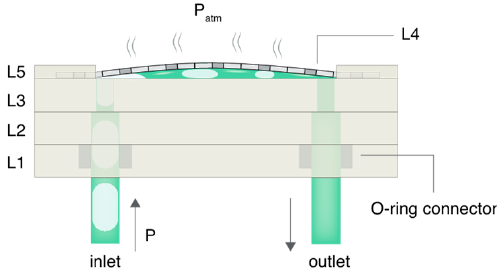
Figure 2. Schematic representation of the RID module in operation. Once the opening pressure P open is exceeded, the PTFE membrane (L4) deflects and exposes a fluidic path connecting the inlet and outlet. Bubbles in the input stream make contact with the hydrophobic PTFE membrane and are removed as a result of the di ff erential pressure between the air-liquid fluid stream and the atmosphere. The liquid is unable to move through the membrane below the critical liquid entry pressure, P critical . As air bubbles are removed, liquid plugs recombine to form a single-phase flow exiting the RID